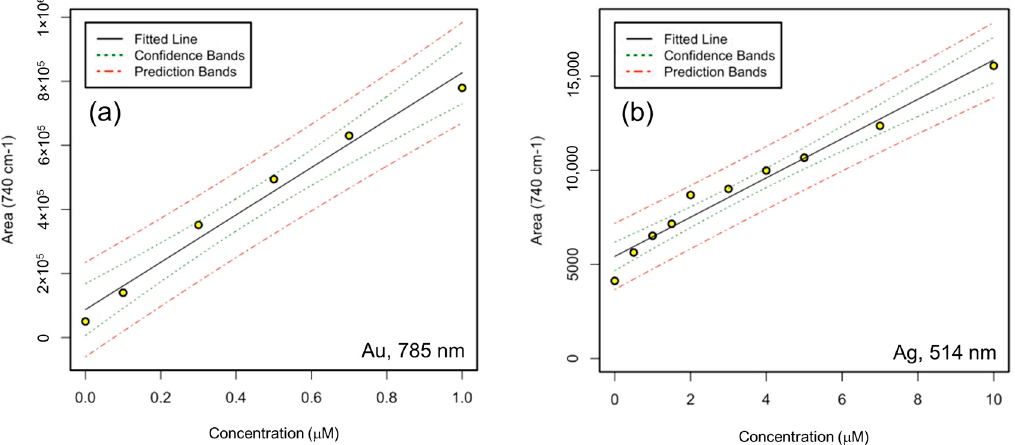
Figure 6. Calibration curves with 95% confidence (uncertainty in the curve estimation) and prediction (uncertainty about the new values on the curve) intervals for concentration ranges with a linear response, for adenine on Au substrates ( a ) at 785 nm and on Ag substrates ( b ) at 514.5 nm. Yellow-filled black represent the values of the integrated areas of the adenine band centered at 740 cm − 1 .